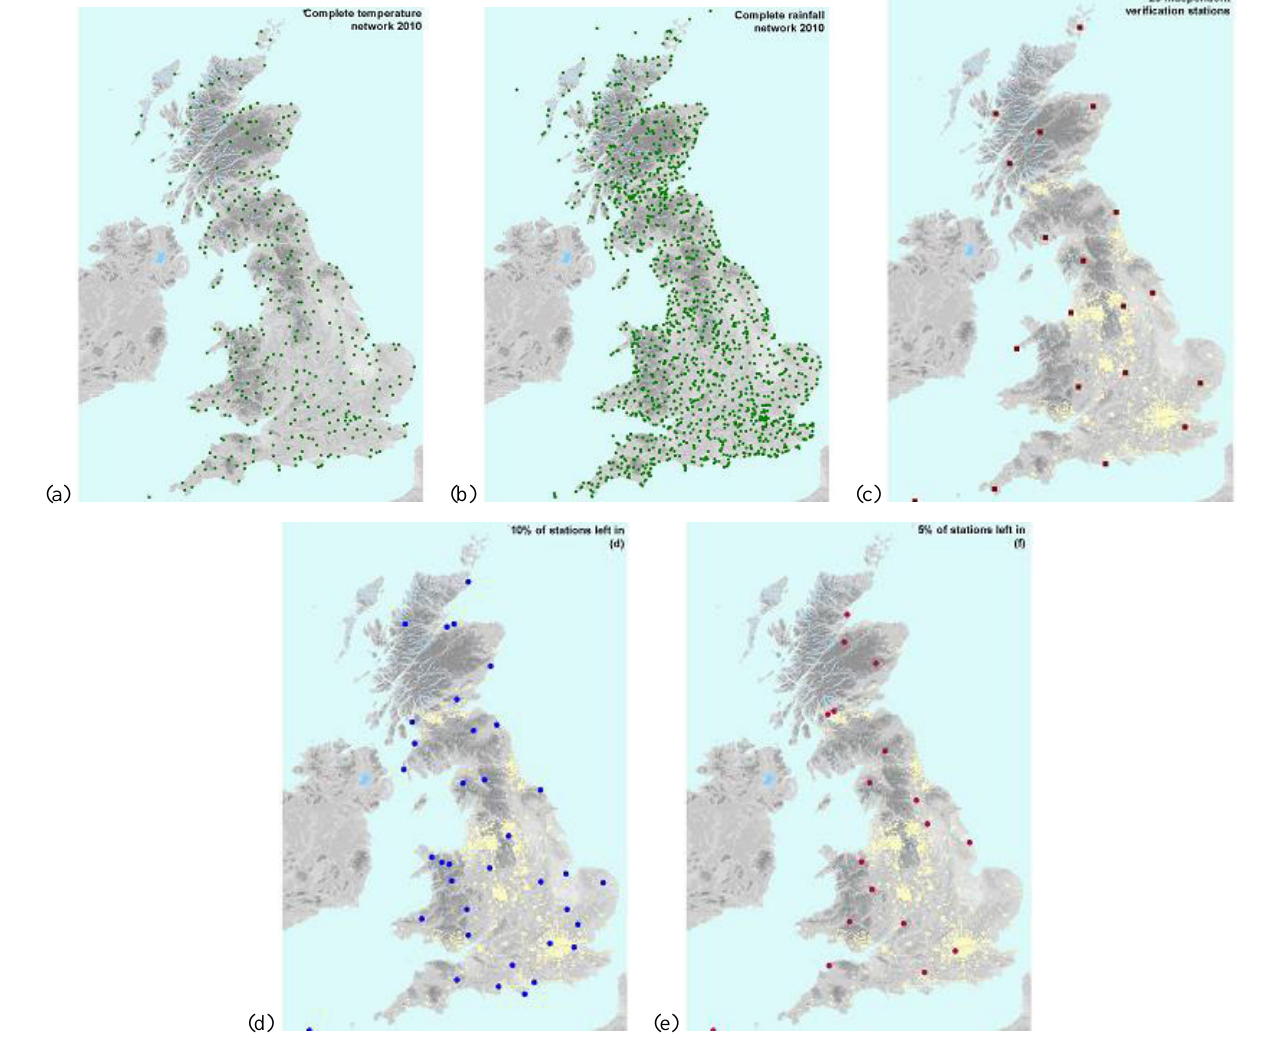
Figure 1. UK station networks for temperature and rainfall; 20 independent verification stations; examples of thinned-out subsets of the network. (a) Full station network for temperature observations. (b) Full station network for rainfall observations. (c) 20 independent verification stations. (d) Example of selection of stations left in network when 90% were removed. (e) Example of selection of stations left in network when 95% were